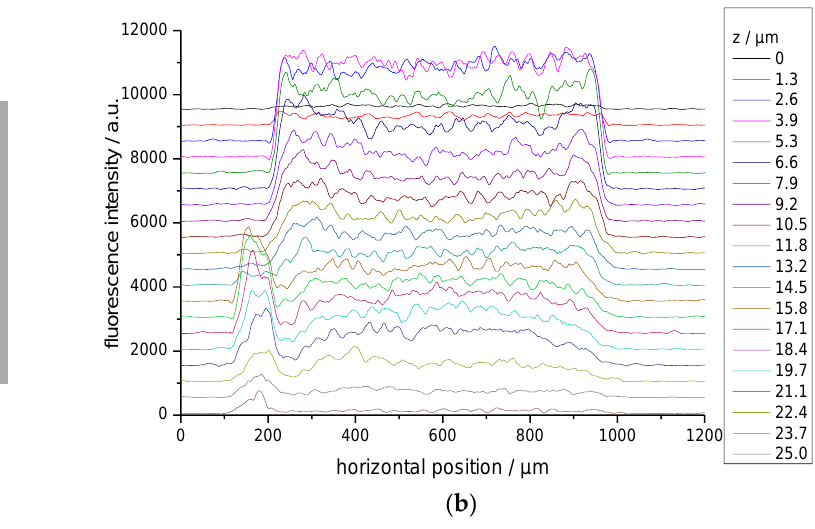
Figure 4. ( a ) Confocal laser scanning microscopy 3D profile for a height z of 25 µm, ( b ) line profile along z of 6F-MIA@MOF-5 (cw excitation at λ ex = 458 nm, λ em = 530–555 nm, objective UP- LSAPO10X/0.4NA). The fluorescence intensity decreases with the depth due to the inner filter effect.